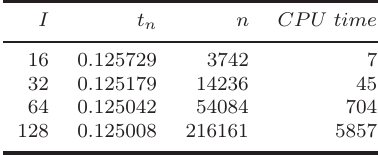
Table 6. The implicit Euler method for ε = 1 / 10000 .